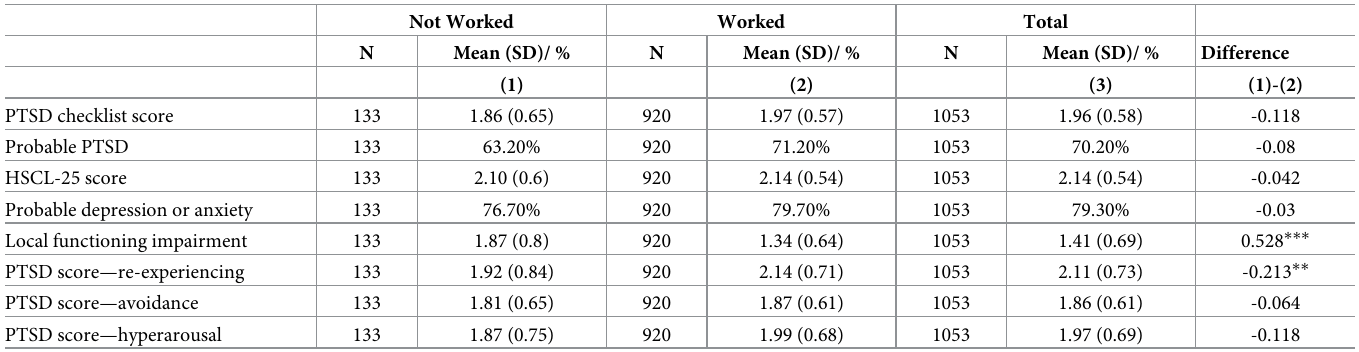
Table 2. Mental health outcomes by work status at baseline, full